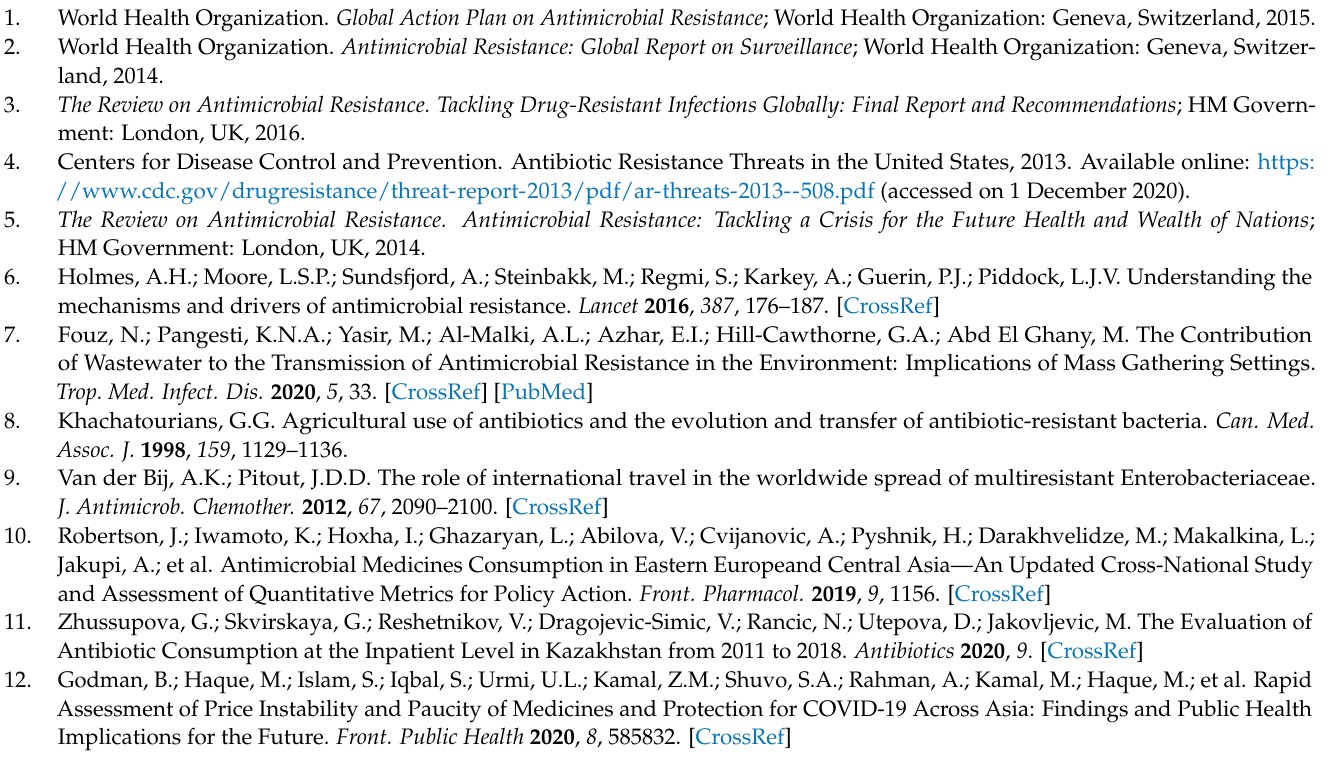
Table S4. Top destination regions for AMR organisms (destination), Table S5. Number of studies and isolates for species that were documented in the analyzed studies, Table S6. Numbers of travel- related AMR isolates documented in 238 studies, up to June 2019 inclusive, categorized by source and isolation time, Table S7. Number of travel-related isolates for enteric organisms with documented AMR component, Table S8. Antimicrobials categories that were included in the